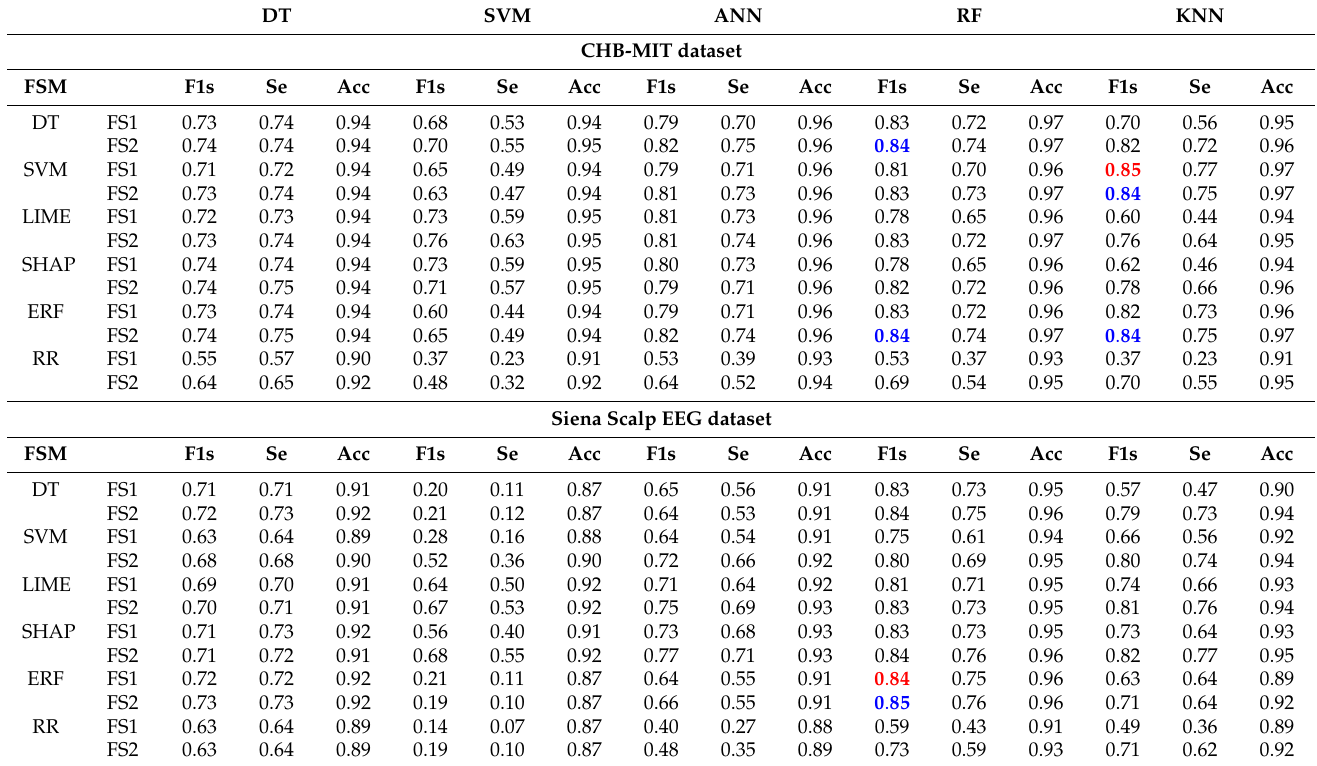
Table 9. Performance comparison using 50 features. The largest F1-scores are displayed in red bold and blue bold for FS1 and FS2, respectively. F1s = F1-score, Se = sensitivity, Acc = accuracy. DT SVM ANN RF KNN CHB-MIT dataset